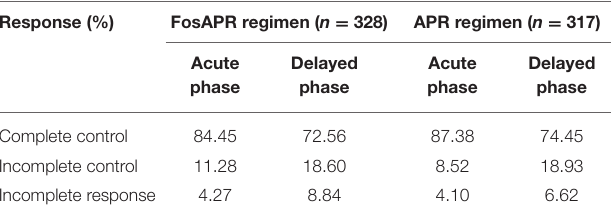
FosAPR: fosaprepitant; APR: aprepitant.